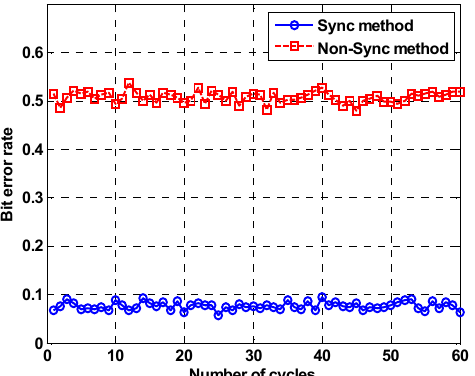
Figure 12. Simulation result using Watermark benchmark model.